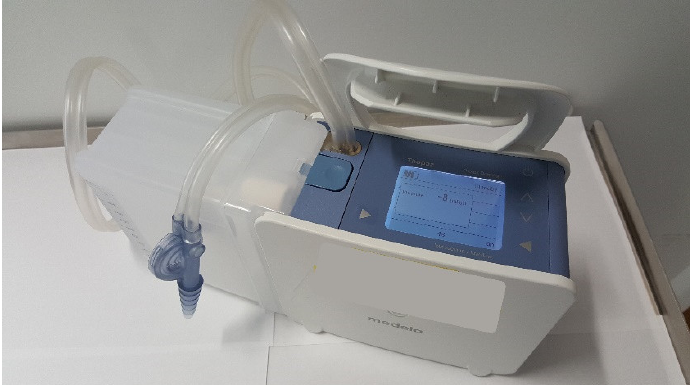
Figure 3. The Thopaz digital air leak drainage